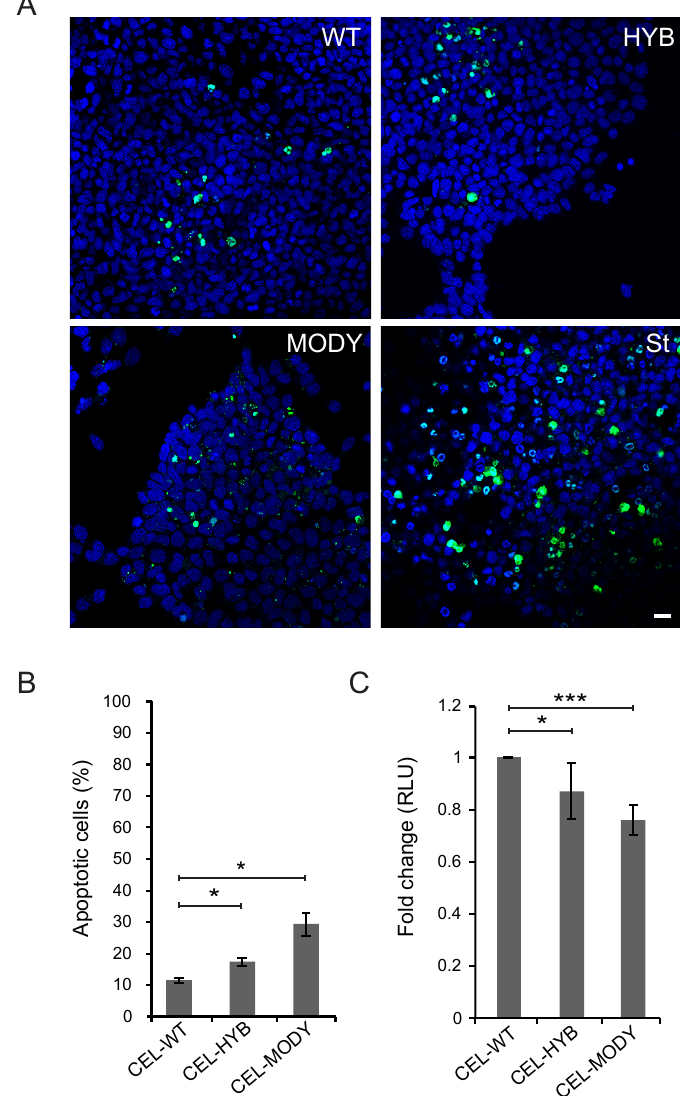
Figure 2. E ff ect of endocytosed CEL-HYB on apoptosis and viability of pancreatic acinar cells. 266-6 cells were cultured for seven days in the presence of conditioned medium from HEK293 cells stably expressing CEL-WT, CEL-HYB, or CEL-MODY. ( A ): Apoptosis was assessed by visualization of caspase-3 / 7 activity in the 266-6 cells exposed to di ff erent CEL protein variants. As positive control, cells were treated with 0.5 µ M staurosporine (St). Scale bar is 50 µ m. ( B ): Quantification of the experiment showed that CEL-HYB caused elevated induction of apoptosis compared with CEL-WT, but lower than for CEL-MODY. For each variant, a total of 500–700 cells were counted in three independent experiments. ( C ): Cell viability was analyzed by measuring the intracellular level of ATP. 266-6 cells exposed to CEL-HYB exhibited reduced viability compared to cells exposed to CEL-WT, but not as much as for CEL-MODY. The experiment was repeated three times, each with 9–12 parallels per condition. Error bars represent SEM (n = 3); * and *** denote p < 0.05 and p < 0.001, respectively. RLU, relative light